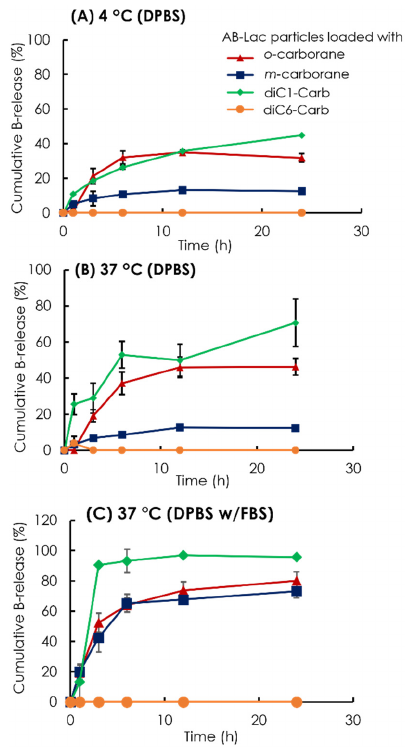
Figure 4. Time-dependent % leakage of B from the AB-Lac particles loaded with o -carborane, m -carborane, diC1-Carb, and diC6-Car by dialysis at 4 °C ( A ) and 37 °C ( B ) against DPBS and 37 °C against DPBS with 10% FBS ( C ). The B release was measured by taking the solution outside the dialysis bag at respective time points using ICP-AES. Data are expressed as mean ± S.E.M. ( n = 3).